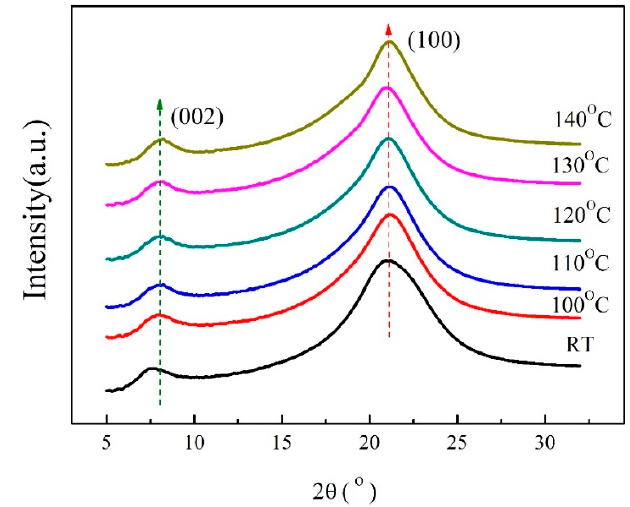
ff erent annealing